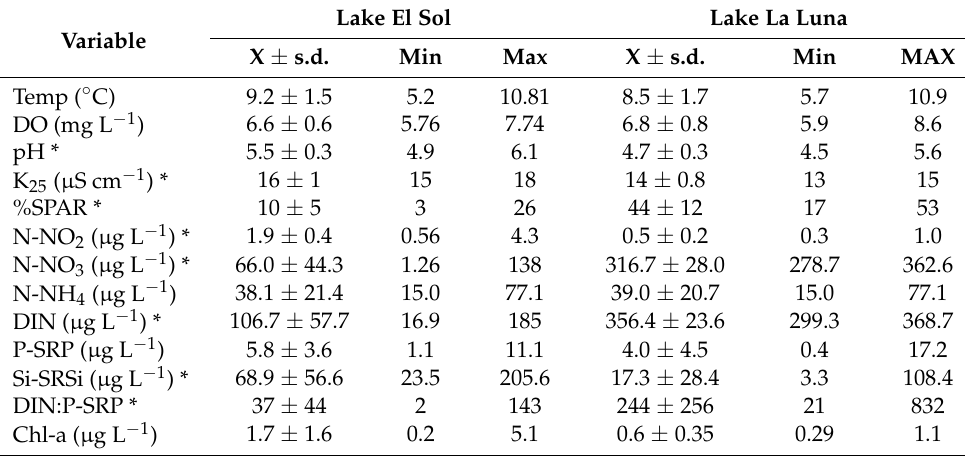
Figure 1. Lakes El Sol and La Luna [lower panels], the Estado de Mexico and Mexico [upper panel]. Table 1. Environmental variables (average ± standard deviation, minimum, maximum) of Lakes El Sol and La Luna, Nevado de Toluca. (Temp = temperature, DO = dissolved oxygen, K 25 = electrical conductivity, %SPAR = percentage of photosynthetic active radiation (PAR) at the bottom, N-NO 2 = nitrogen as nitrites, N-NO 3 = nitrogen as nitrates, N-NH 4 = nitrogen as ammonium, DIN = dissolved inorganic nitrogen, P-SRP = phosphorous as soluble reactive phosphorous, Si-SRSi = silica as soluble reactive silica, Chl-a = chlorophyll a). [* Statistically different ( α < 0.05)]. (Data from [22,23]).